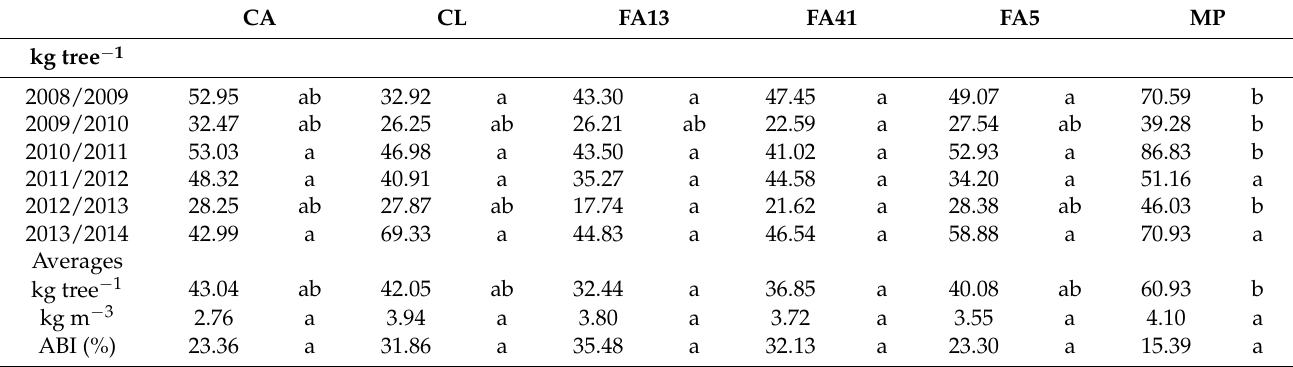
Table 4. Effect of rootstocks on the yield and average of yield (kg tree − 1 ), yield efficiency (kg m − 3 ), and alternate bearing index (ABI) of ‘Lane Late’ navel orange trees over six growing seasons (2008/2009–2013/2014). CA CL kg tree − 1